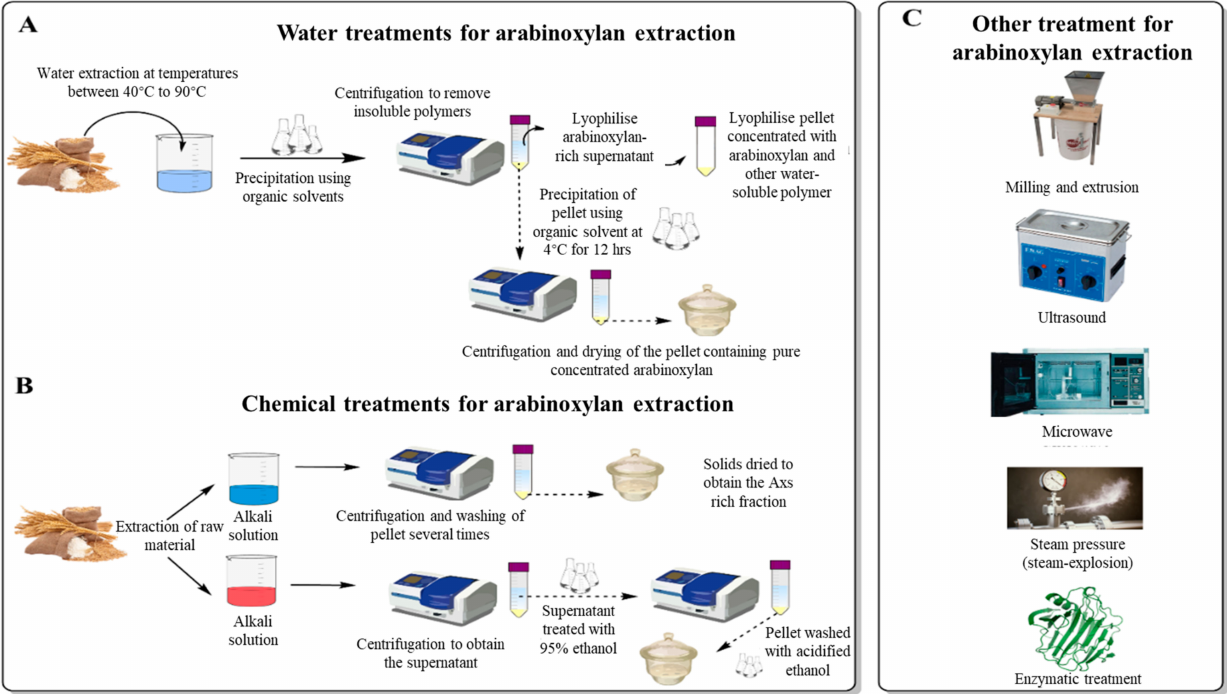
Figure 1. Schematic illustration of a water treatment approach ( A ) to extract AXs from cereal grains. ( B ) demonstrates a different approach using acidic or basic chemical solutions to extract AXs. Other treatments ( C ), including mechanical (milling and extrusion, steam-pressure, ultra-sound, microwave) and enzymatic treatments, are also